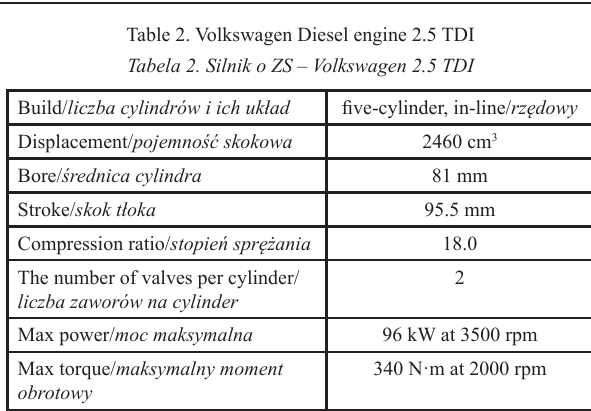
The impact of the piston bearing surface stepped profile Table 2. Volkswagen Diesel engine 2.5 TDi Tabela 2. Silnik o ZS – Volkswagen 2.5 TDI